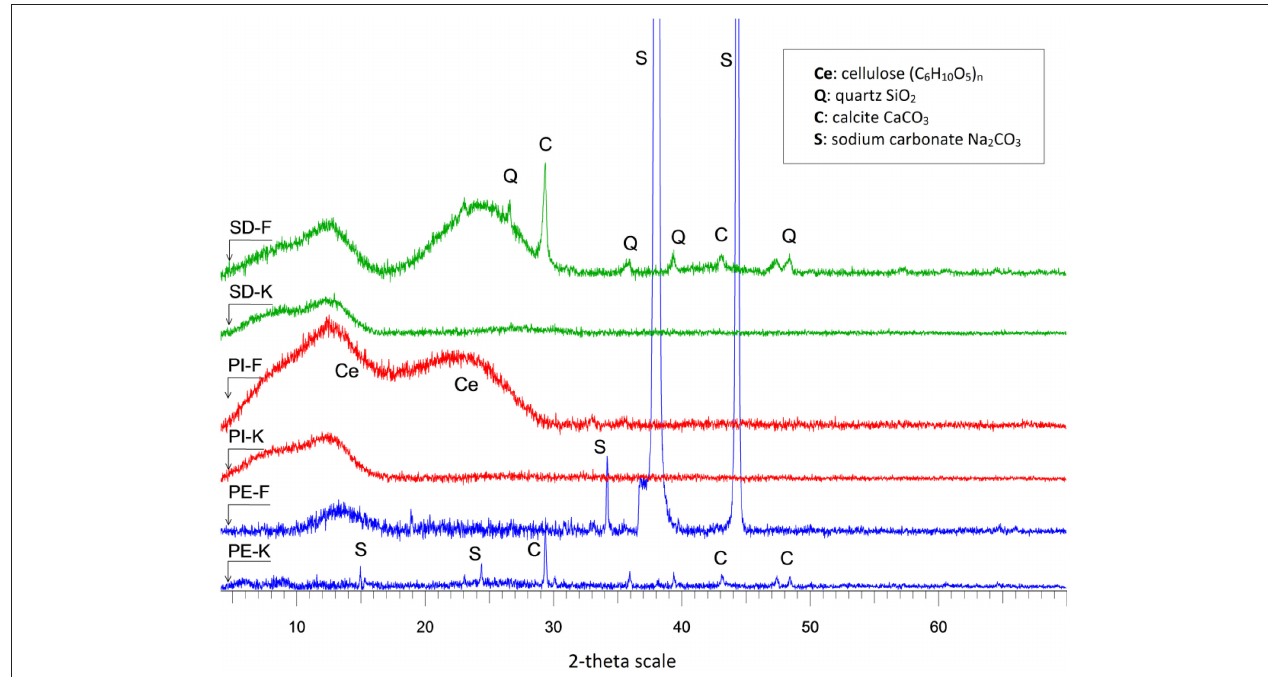
FIGURE 1 | XRD patterns of biochars modified with 1M KOH (PI-K, PE-K, SD-K) or 1M FeCl 3 (PI-F, PE-F, SD-F).